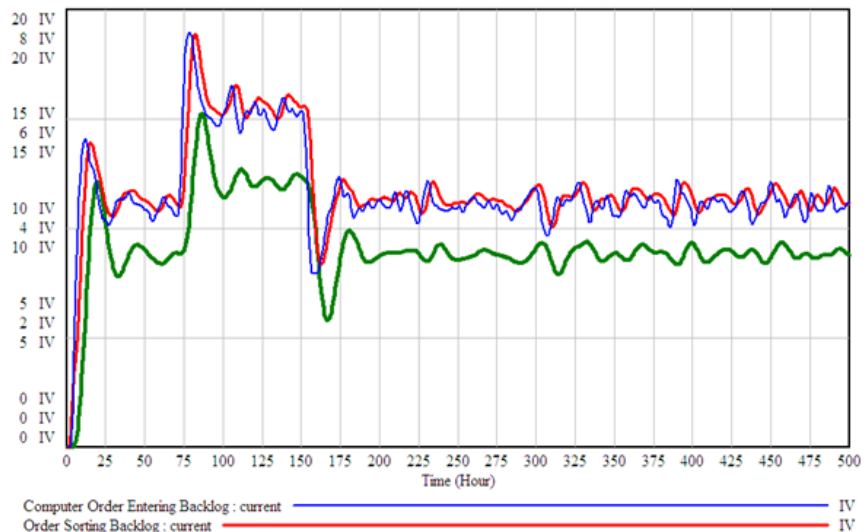
Figure 13. Pharmacy’s